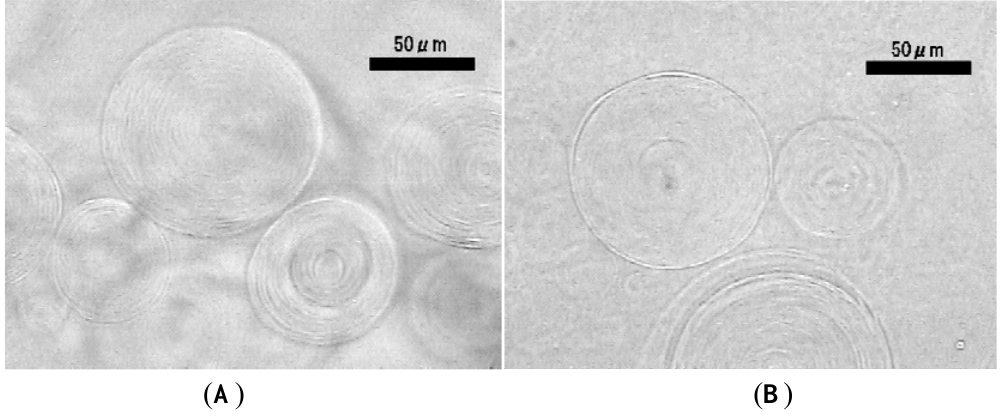
Figure 4. Multilamellar membranous objects formed from lipid deposit on a planar ITO formation electrode by applying ac voltage (3.0 Vpp, 2.0 Hz) using a double ( A , 120 min) or a single ( B , 110 min) wire counter